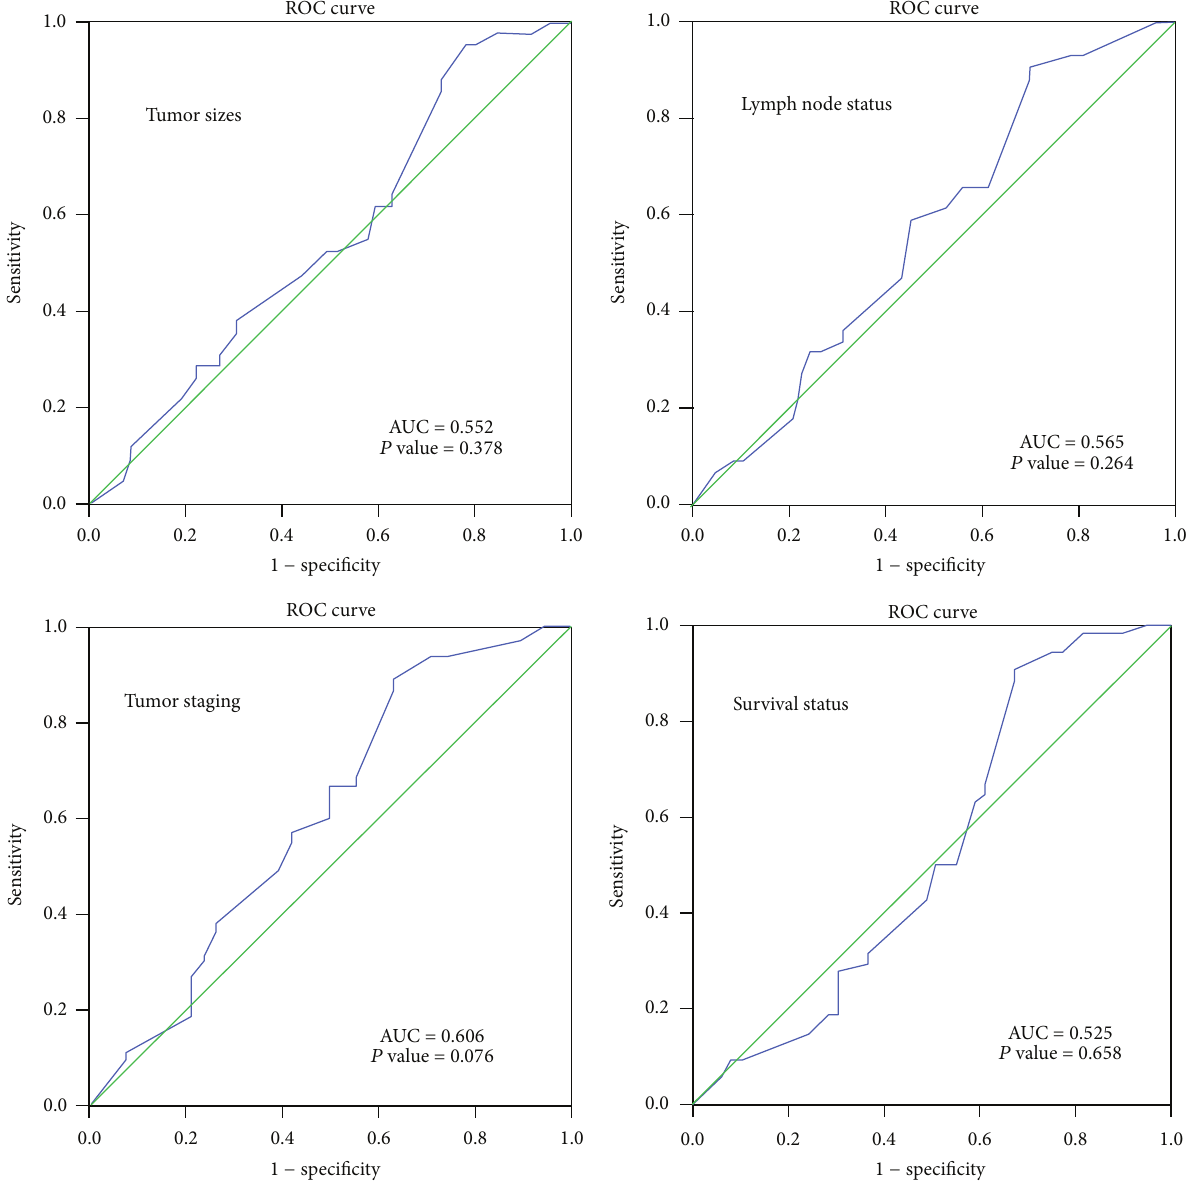
Figure 1: Determination the cutoff value of MMP13 expression in OSCC by receiver operating characteristic (ROC) curves. The clinicopathological parameters including lymph node metastasis, tumor staging, tumor sizes and survival status, the sensitivity, and 1 − specificity were plotted. The areas under curve (AUC) and the 𝑃 value were